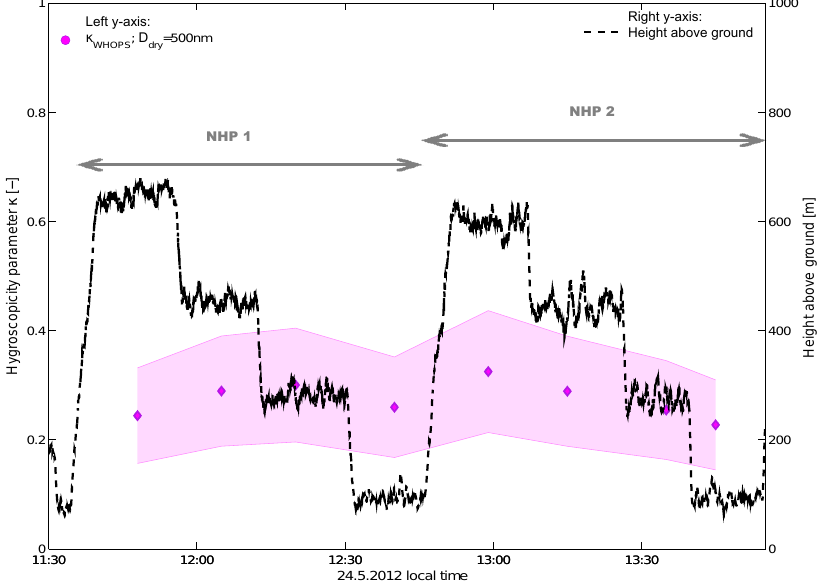
Figure 13. Time series of κ values retrieved during the flight on 24 May 2012. WHOPS results for a dry diameter of 500nm are presented. The measurement accuracy is shown as the shaded area. Additionally, the flight altitude is indicated.